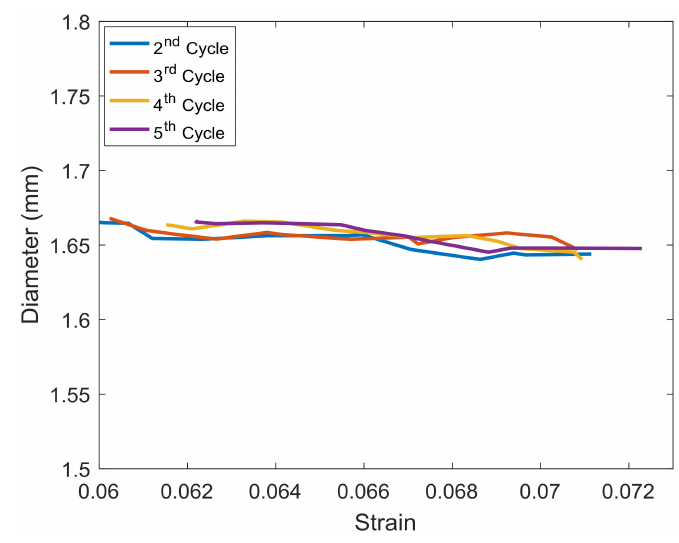
Figure 9. Change in diameter of rope for the second to fifth cycle. Table 4. Linear density (tex) and cross-sectional area of the